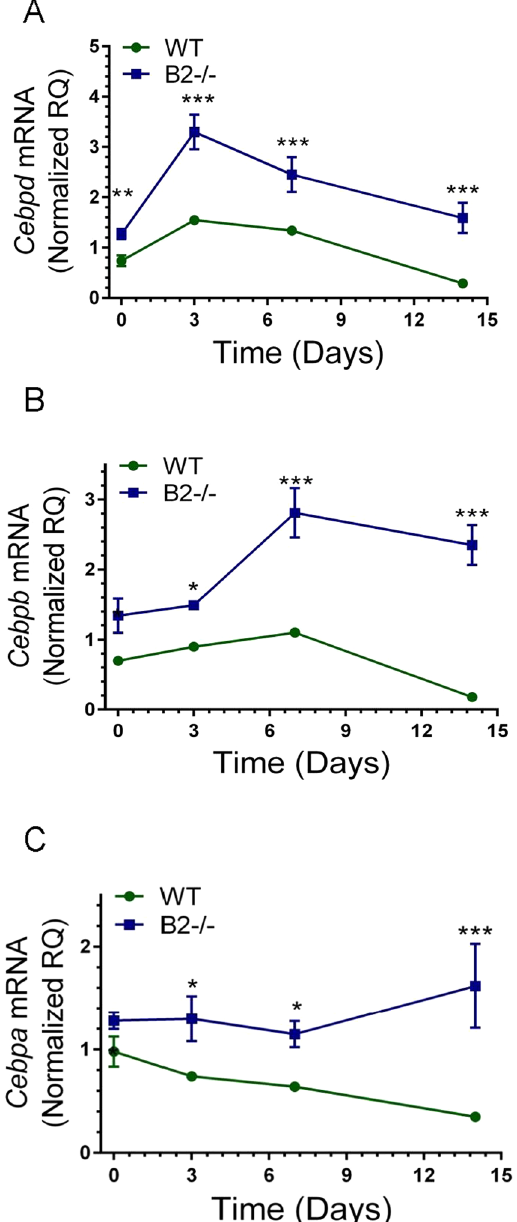
Figure 9. Endophilin B2 uncouples the temporal expression of CEBP transcription factors in IAV infected lugs. The expression of ( A ) Cebpd , ( B ) Cebpb , and ( C ) Cebpa mRNA were quantitated by qRT-PCR in total lung. Data were normalized to 18 S RNA and expressed as relative quantity (RQ) compared to WT uninfected control treated with DPBS vehicle. *** p < 0.00001, ** p < 0.007, * p < 0.02 (for WT n = 4, 9, 8, and 6 and B2 − / − n = 3, 7, 8, and 6 at t = 0, 3, 7, and 14 days; the vehicle treated mice are plotted as t = 0. Data ± SEM are from 2 independent